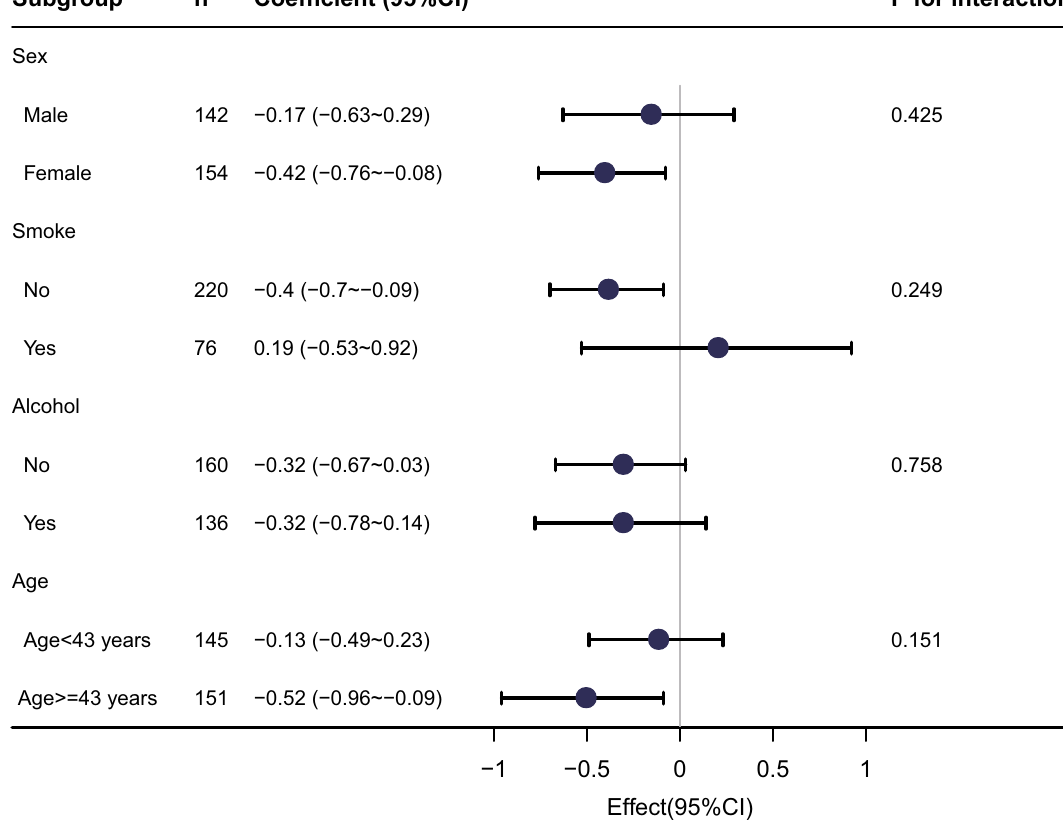
Figure 2. Subgroup analyses of the association between altitude and serum folate